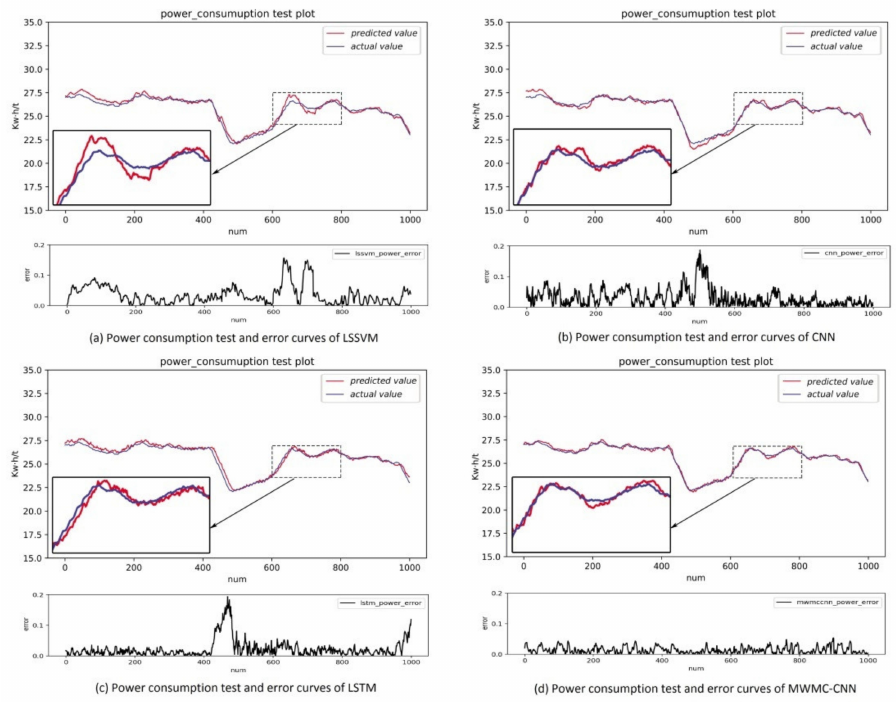
Figure 9. Electricity consumption test and error curves of LSSVM, CNN, LSTM and MWMC-CNN.